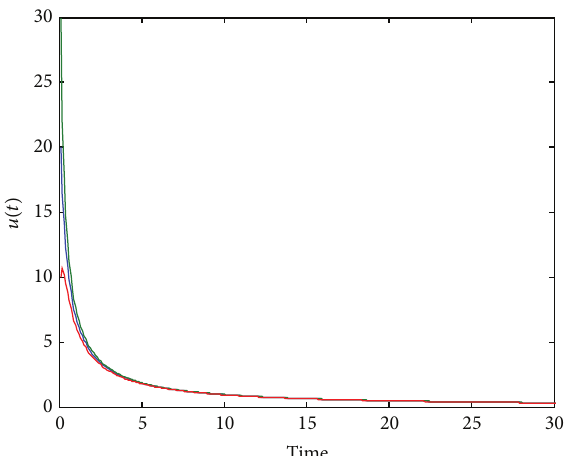
Figure 3: Behavior of each node for 𝑝 = 3 and 𝜆 = 0.9 .